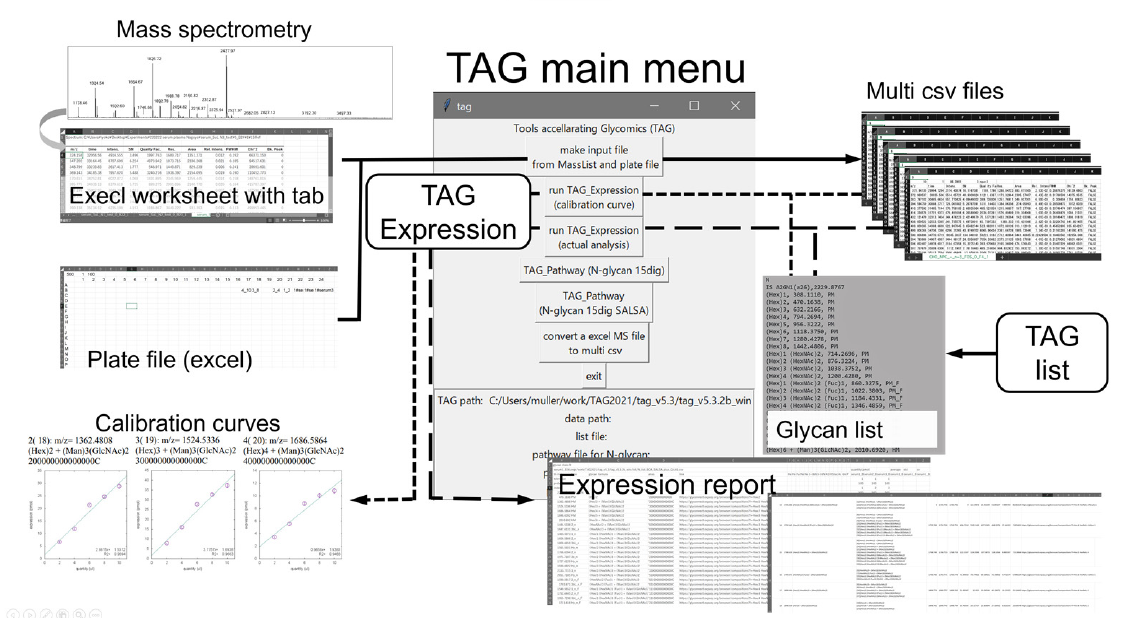
Figure 3. Overview of the updated version of Toolbox Accelerating Glycomics (TAG) showing TAG Expression and related programs. Table 2. Updated functions of TAG.